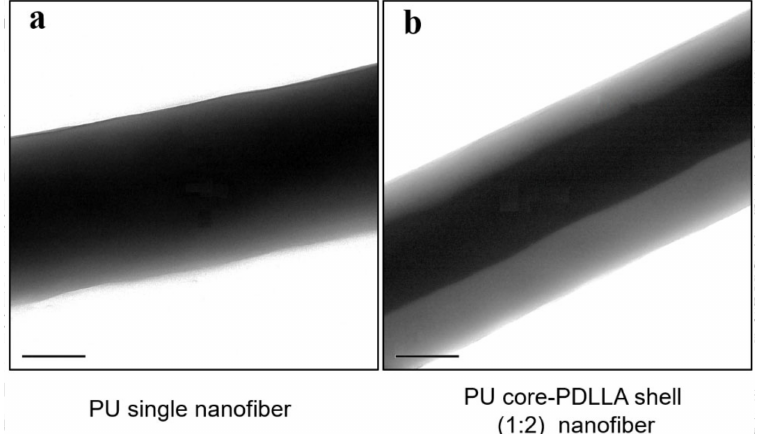
Figure 3. Transmission electron microscopic images of single and core-shell (1:2) electrospun nanofibers. ( a ) PU single nanofiber. ( b ) PU core–PDLLA shell (1:2) nanofiber. Thickness of single nanofiber layer and core-shell nanofiber was around 0.51 µ m and 0.47 µ m (0.25 µ m for core and 0.11 µ m for shell) in the TEM images, respectively. The scale bar represents 0.2 µ